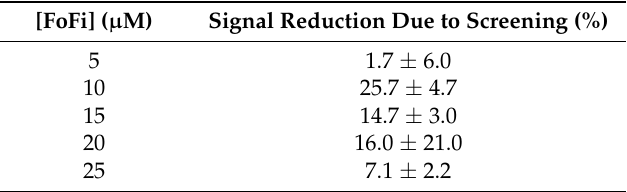
Table 2. Coefficients for signal loss (%) from protein (BSA) screening across varying FoFi concentrations. Values displayed as mean ± standard deviation ( n = 2).